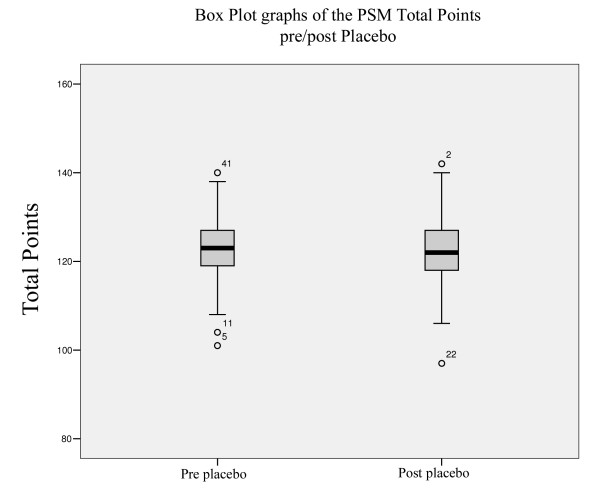
Box Plot Graphs (placebo). Box Plot Graphs of the PSM total points of the placebo.